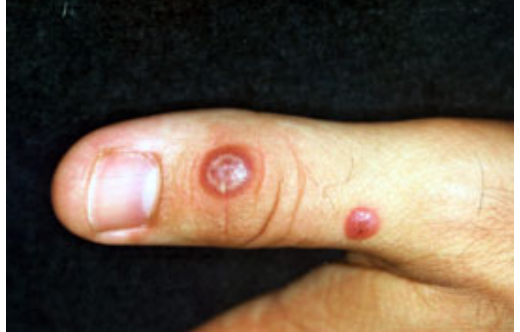
Figure 1: Presence of two violaceous erythematous lesions with central depression.